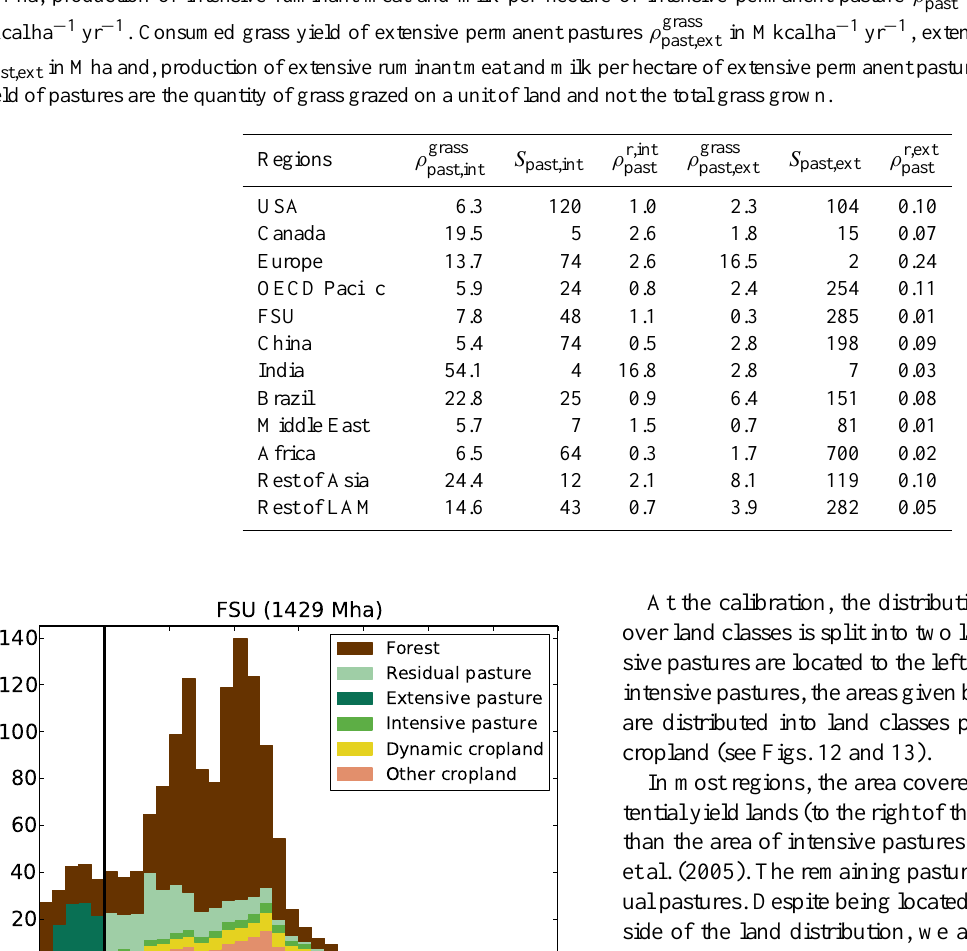
Table 6. Consumed grass yield of intensive permanent pastures ρ grass in Mha, production of intensive ruminant meat and milk per hectare of intensive permanent pasture ρ r,int past ( = ρ grass